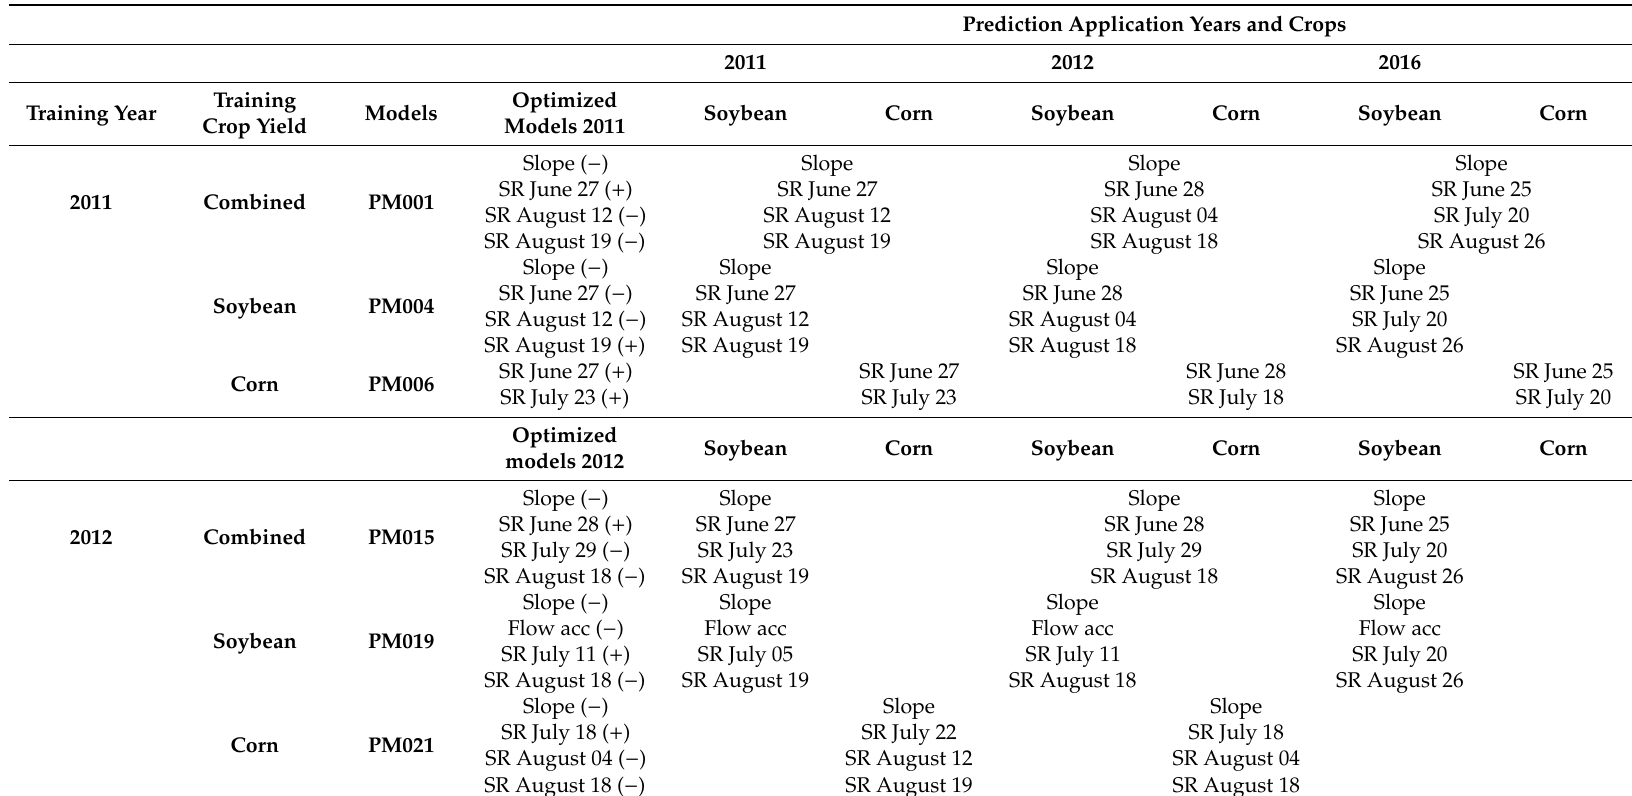
Table A1. Overview of the optimized prediction models and the predictor variables used in testing and application